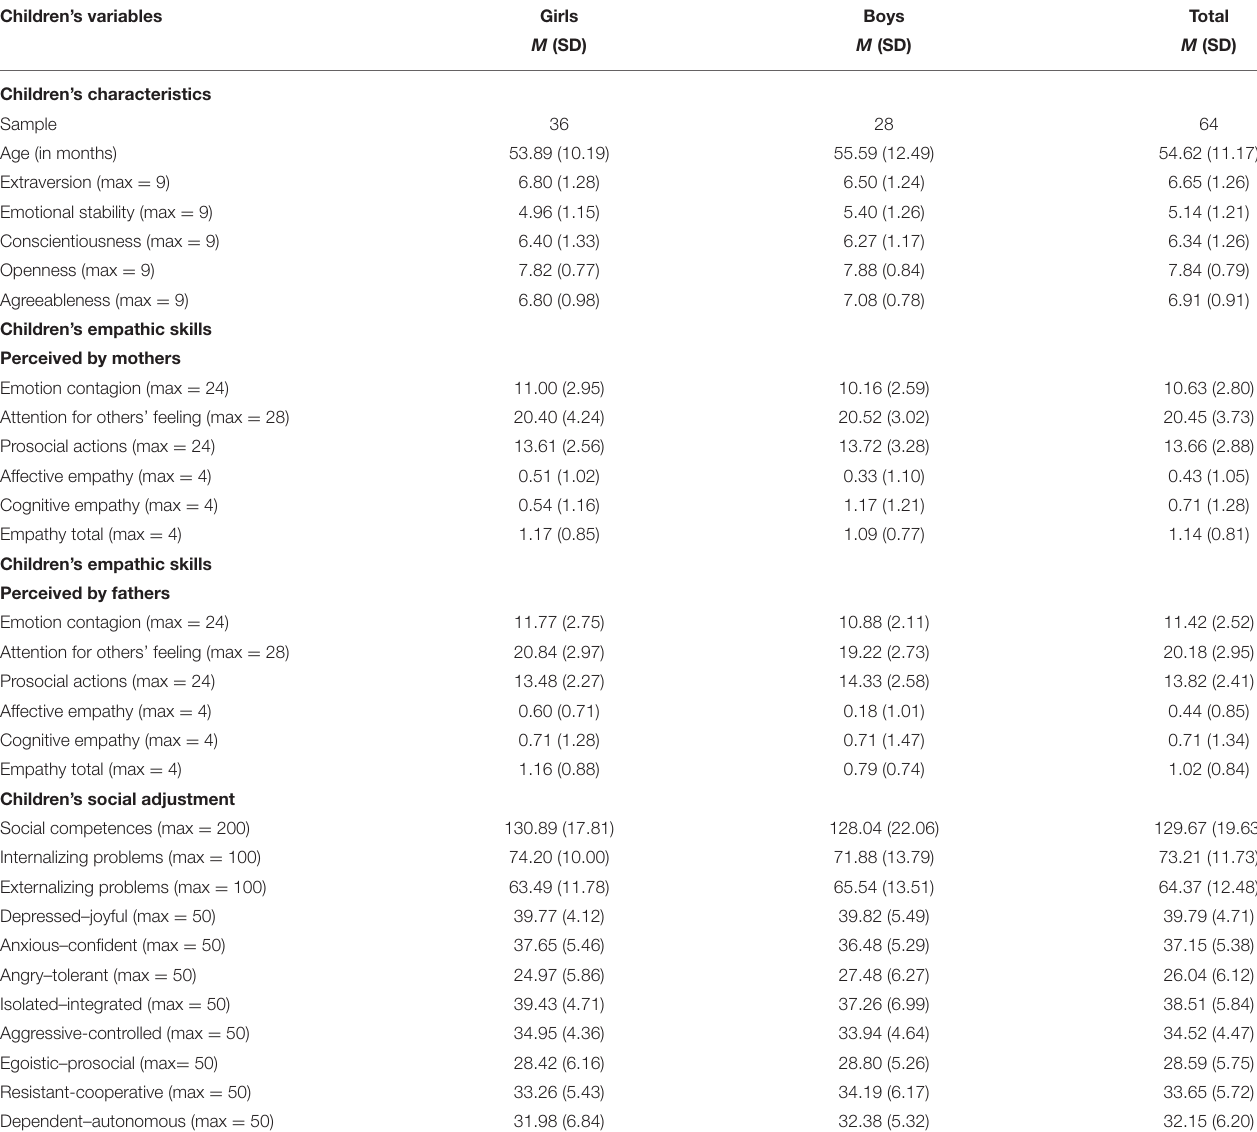
TABLE 1 | Mean scores and standard deviations in children’s characteristics, empathic skills as perceived by both mothers and fathers, and social competences as perceived by parents. Children’s